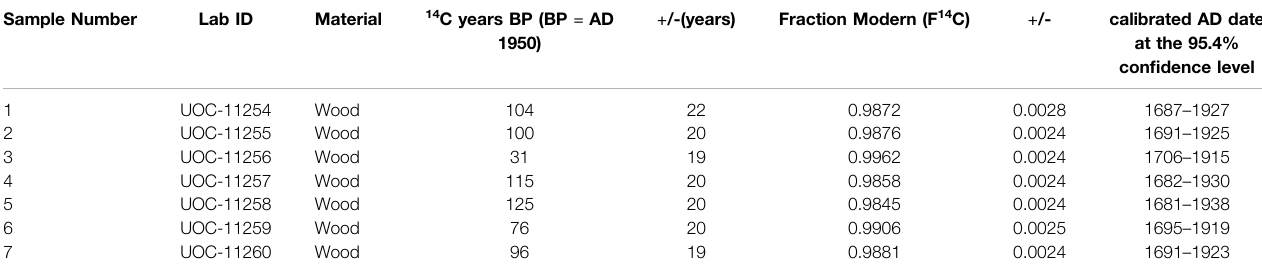
TABLE 4| Radiocarbonsampledatingresultsofthetreestem/branch “ cookies ” takenat theTuktoyaktukHarbor site. Thelocationsofthenumbered samplescanbefound in Figure 5D . Reported dates in the table are from the A.E. Lalonde AMS laboratory analysis report. Sample